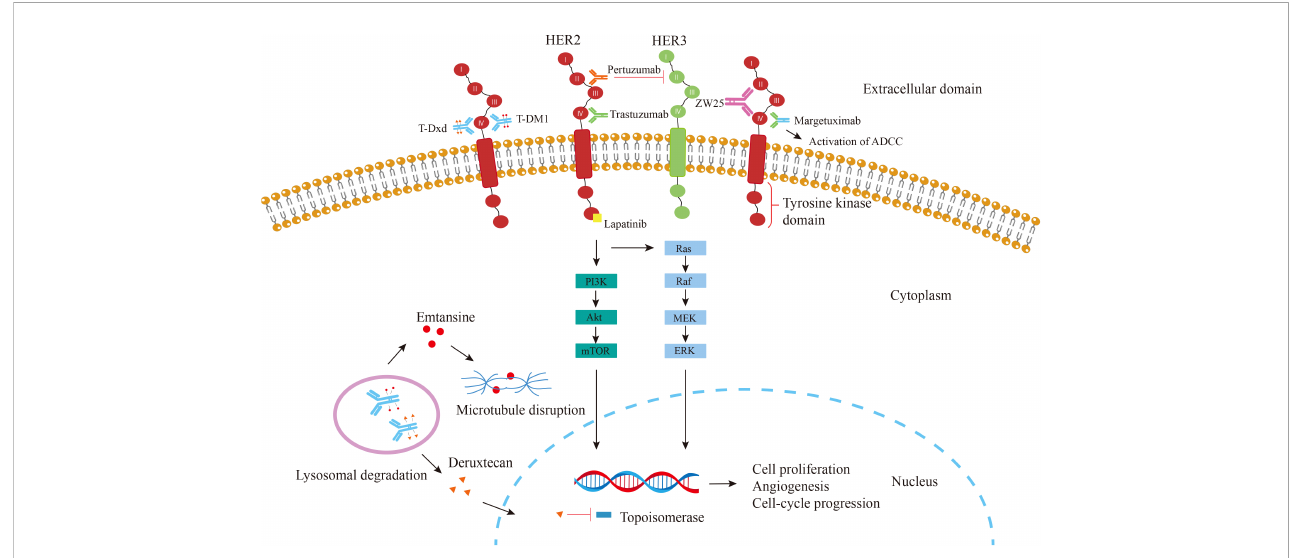
FIGURE 1 Mechanism of action of agents targeting HER2. Trastuzumab (green) binds to the ECD IV of HER2, thereby inhibiting the HER2 signaling pathway leading to cell cycle arrest; Pertuzumab (orange), which binds to the ECD II and Inhibits dimer formation; Margetuximab, which binds trastuzumab to an altered Fc- g domain that involved in ADCC; Lapatinib (yellow) directly prevents the PI3K pathway from being activated by binding to the intracellular tyrosine kinase domain of HER2; T-DM1 (red circle)releases the emtansine moiety after the ADC is phagocytosed by lysosomes; T-Dxd (orange triangle), another ADC combining trastuzumab and deruxtecan, a potent topoisomerase I inhibitor; Bispeci fi c antibody ZW25 (purple) binds to both extracellular domains II and IV of